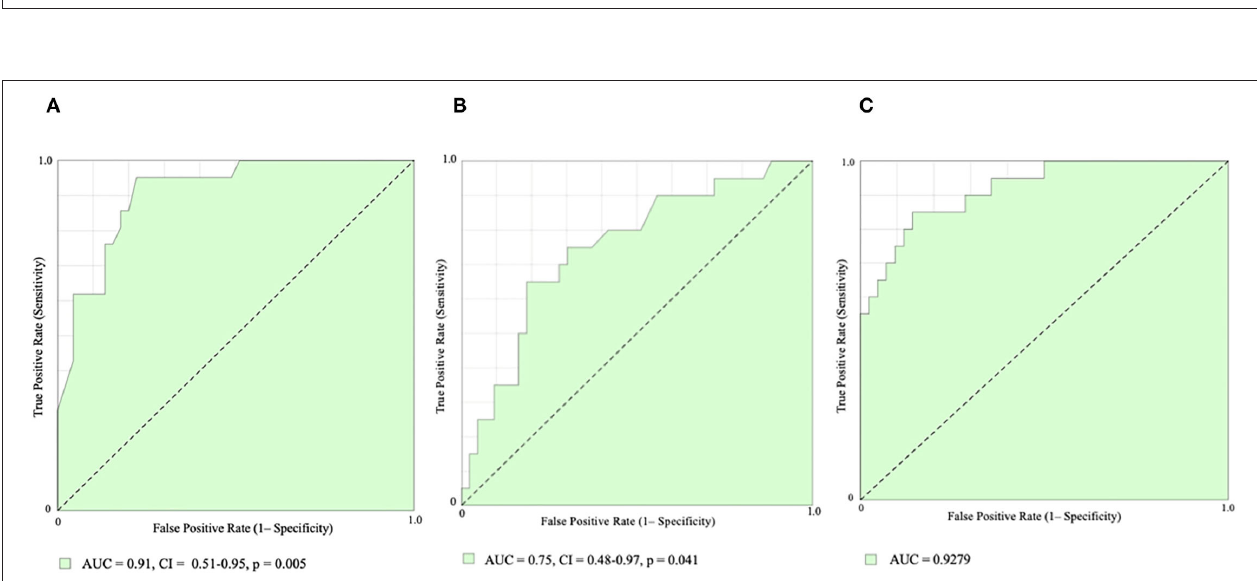
FIGURE 3 | Receiver-operating characteristic (ROC) curve analysis. Peak Atrial Contractile Strain [PACS, (A) ], Left Ventricular Longitudinal Strain [LVLS, (B) ], and PACS combined with LVLS (C) for AF prediction. AUC, area under curve.